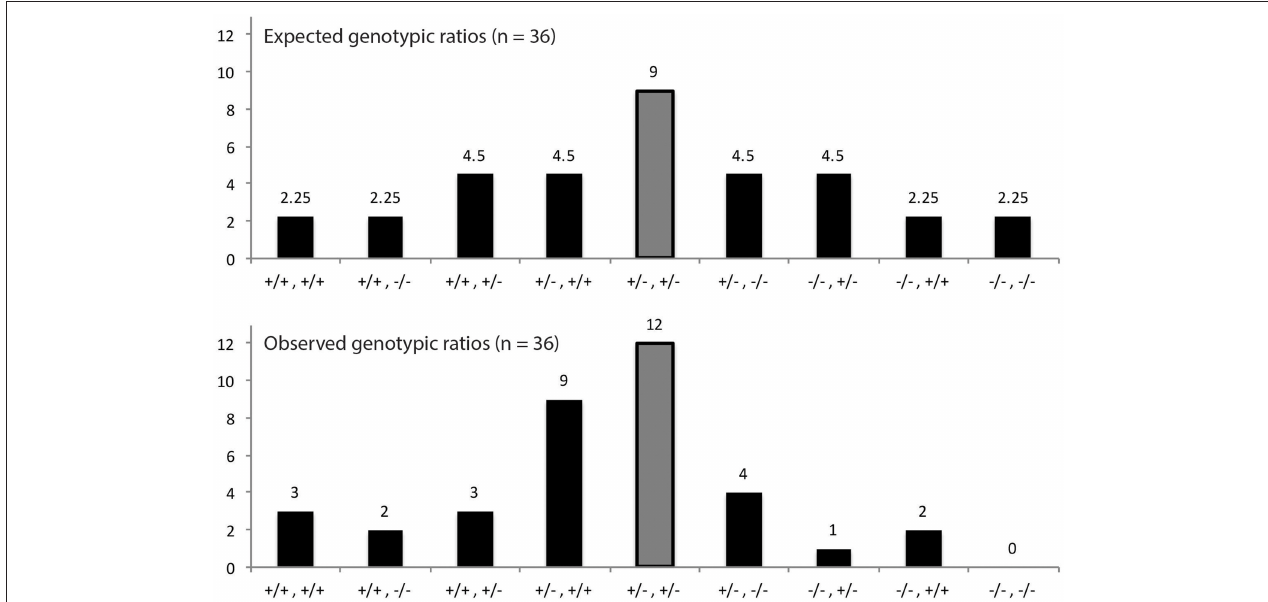
FIGURE 7 | Proportion of genotypes from DNA PolIA × PolIB crosses. The results come from 36 plants that were able to successfully grow on soil. The horizontal axes represent the possible genotype combinations starting with PolIA and followed by PolIB (e.g., + / − , + / − represents PolIA + / − , PolIB + / − , respectively). The middle bar represents the heterozygous combination of genes and is highlighted gray for convenience. Because the results are only from surviving plants, certain genotypes were not observed, such as PolIA − / − , PolIB − / − as this combination most likely is lethal to the plant. A particularly interesting genotype was PolIA + / − , PolIB + / + which was present in an uncharacteristically high number of plants.